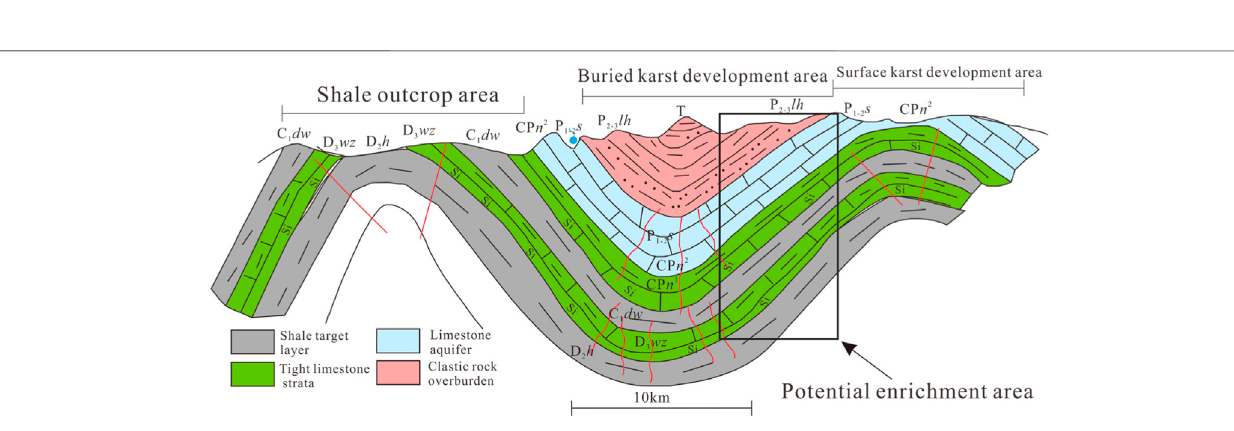
Frontiers in Earth Science |